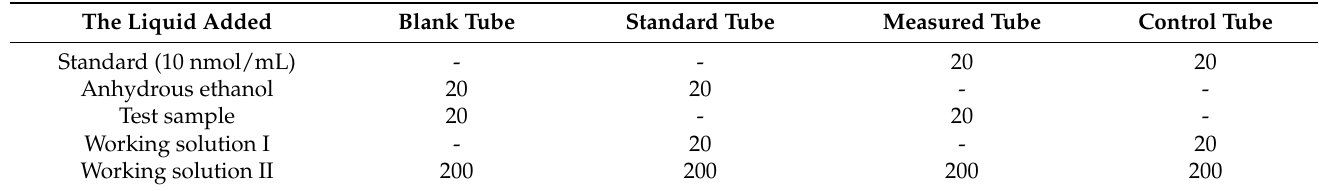
Table 2. Composition of reagents for each tube of MDA content detection